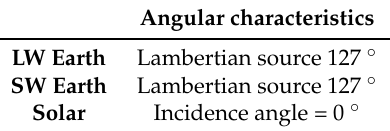
Table 2. Illumination cases.